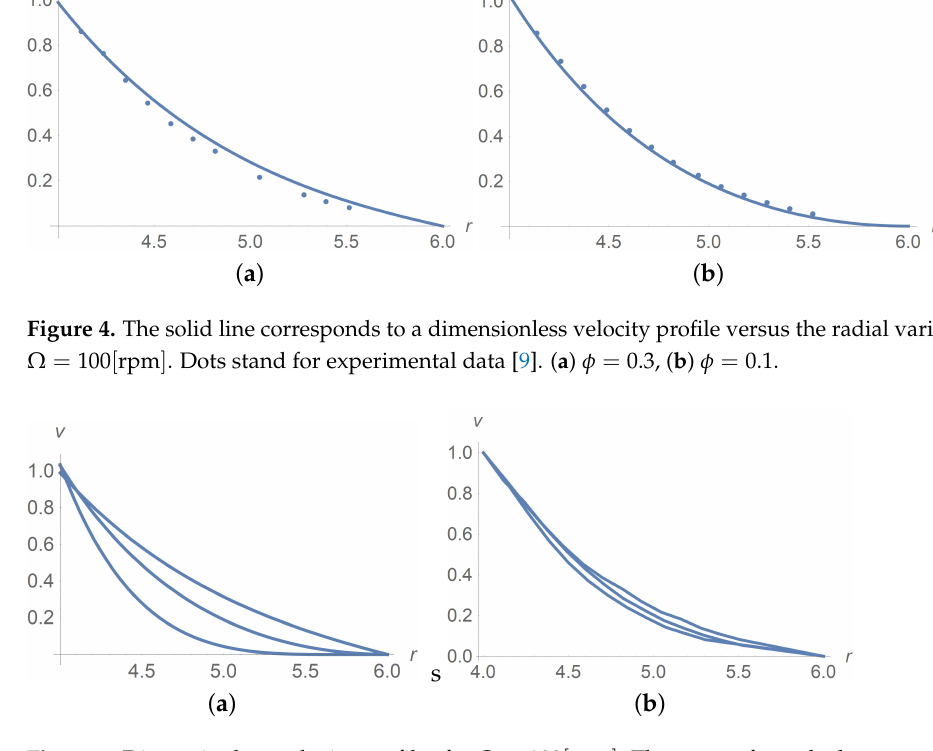
Figure 5. Dimensionless velocity profiles for Ω = 100 [ rpm ] . The curves from the bottom upwards correspond to φ = 0, φ = 0.1 and φ = 0.3. ( a ) Calculations, ( b ) measured data